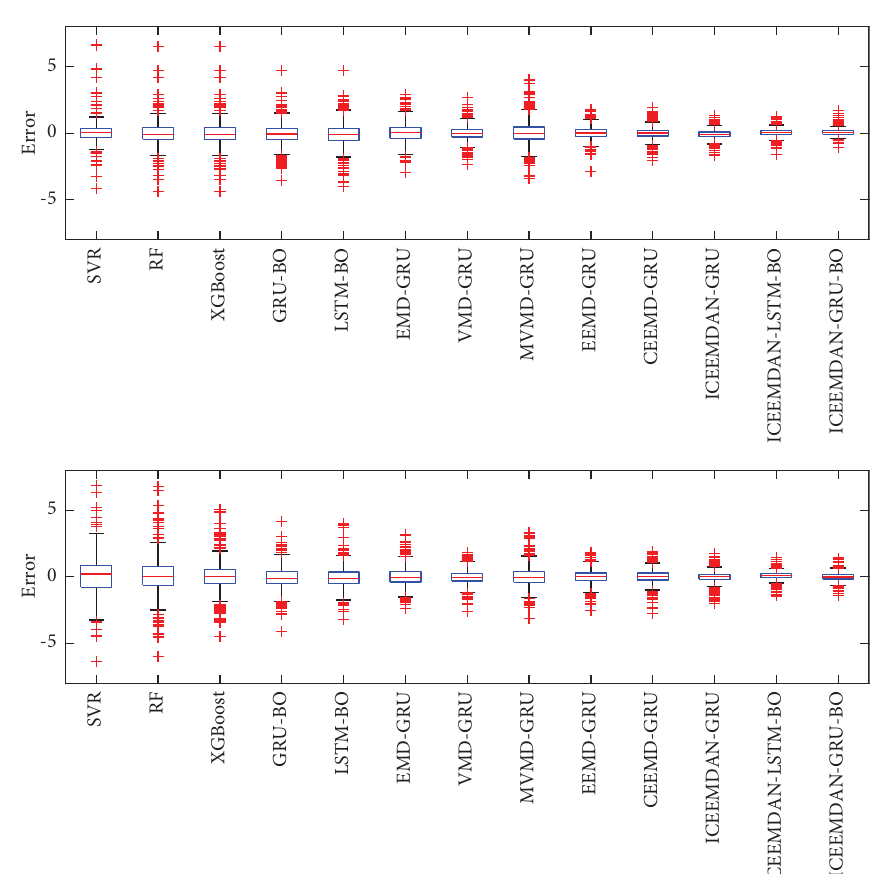
Figure 7: Box plots of prediction errors of diferent